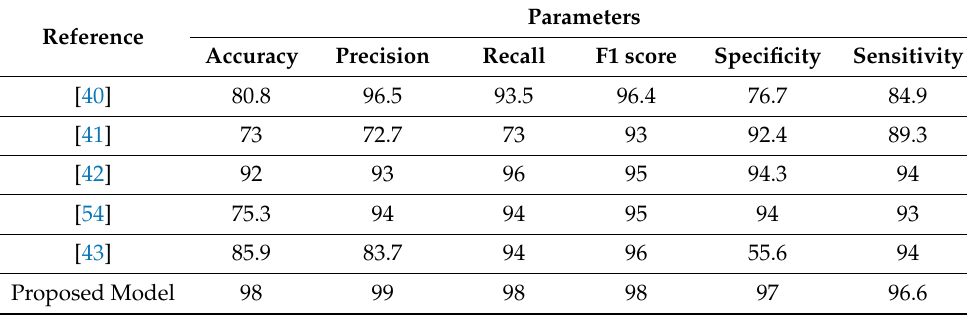
Table 8. Comparison of the results with existing